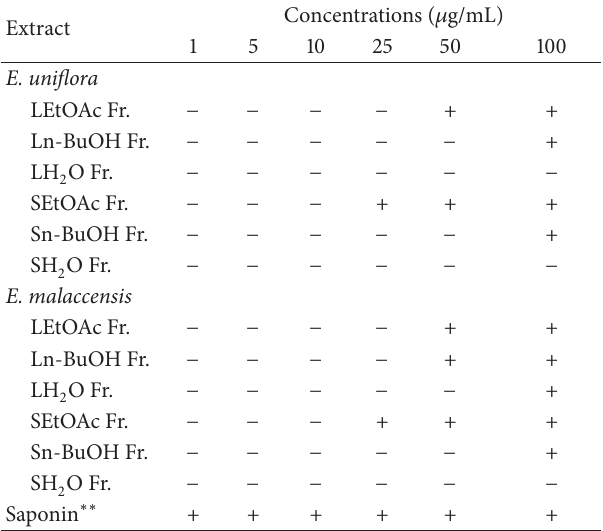
some information about the mechanism of cytotoxicity [27]. Table 2: Cytotoxicity assay using splenocytes from BALB/c mice treated with extracts of E. uniflora and E. malaccensis